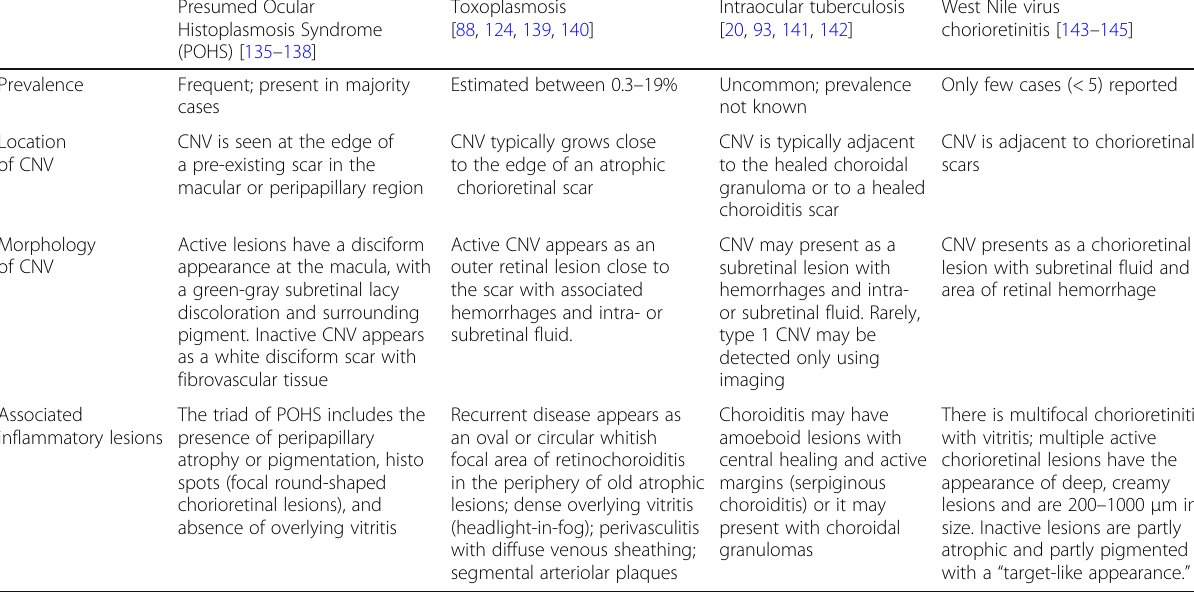
Table 2 Features of inflammatory choroidal neovascularization (CNV) commonly associated with infectious uveitis